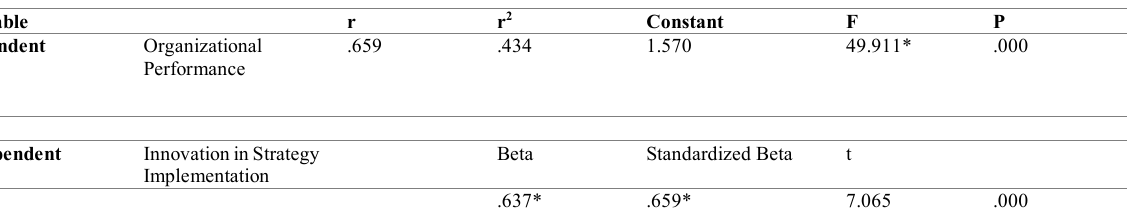
Table 5: Regression Analysis